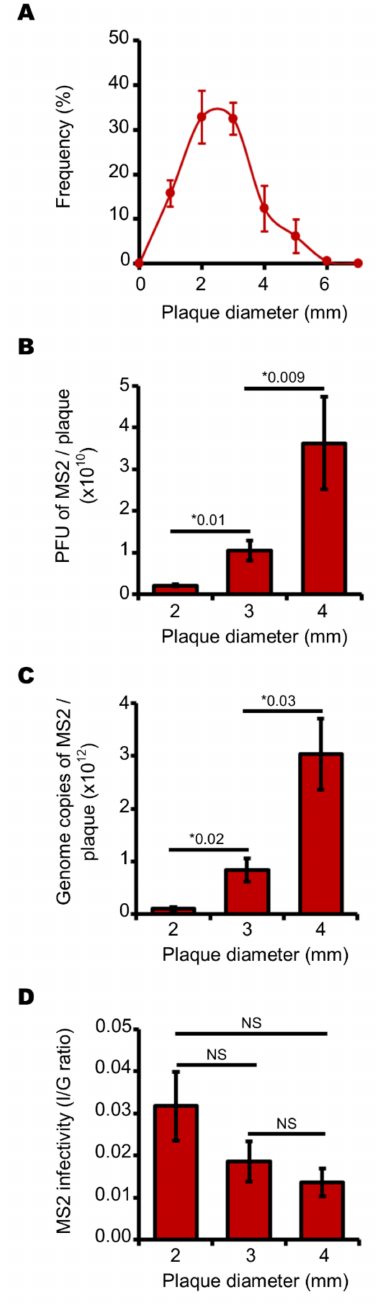
Figure 3. Larger plaques contain more infectious MS2 phages and genomes but phages are slightly less infectious in larger plaques when cultured under aerobic conditions. ( A ) curve showing the normal distribution of plaque diameter (in mm) formed by infectious MS2 phages cultured on a lawn of E. coli . ( B ) histogram showing the increasing number of infectious MS2 phages depending on plaque diameter, ranging from 2.0 to 4.0 mm. ( C ) histogram showing the increasing number of MS2 genome copies depending on plaque diameter, ranging from 2.0 to 4.0 mm. ( D ) histogram showing the slightly decreasing I/G ratio of infectious particles (I) divided by the number of MS2 genome copies (G) depending on plaque diameter, ranging from 2.0 to 4.0 mm. Each data point is an average of several replicates ( n = 7 for panel A ; n = 6 for panels B to D ) obtained on three separate days. Error bars indicate standard errors. “*” stands for “p value” determined as described in the Materials and Methods section. “NS” stands for statistically non-significant: p >